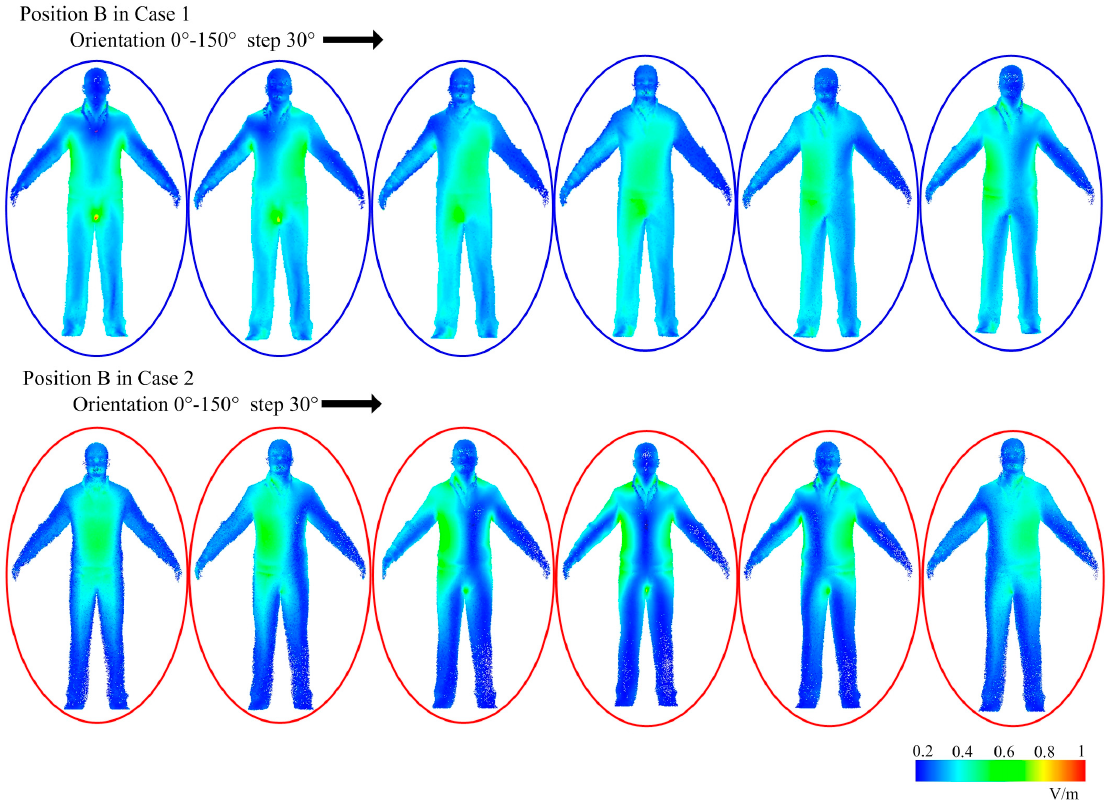
Figure 9. The induced electric field in a standing human body with different orientations at position B.